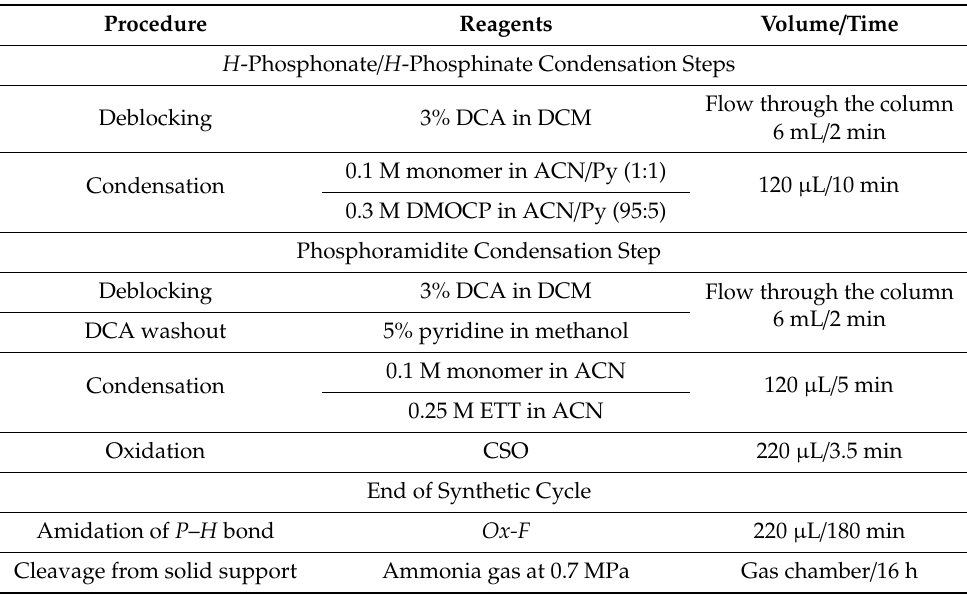
Table 6. Synthetic Protocol C (For more details see Supporting